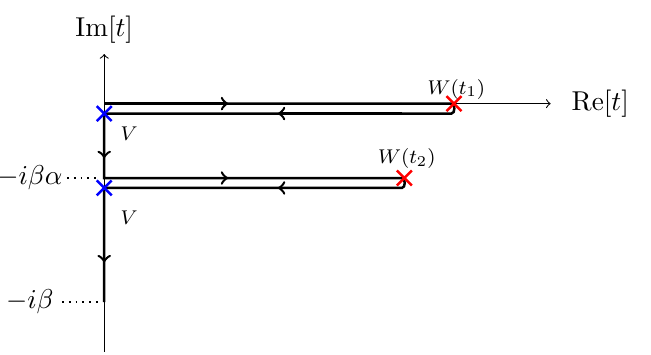
Figure 2 . Extended Schwinger-Keldysh contour corresponding to tr [ (cid:26) (cid:11) W ( t 1 ) V (cid:26) 1 (cid:0) (cid:11) W ( t 2 ) V ] which enters in C ( t ; (cid:12) ) de(cid:12)ned in eq. (2.7). ( (cid:11); 0) one value of (cid:27) is preferred. For the speci(cid:12)c deformation parametrized by (cid:27) , we could not (cid:12)nd an argument for such